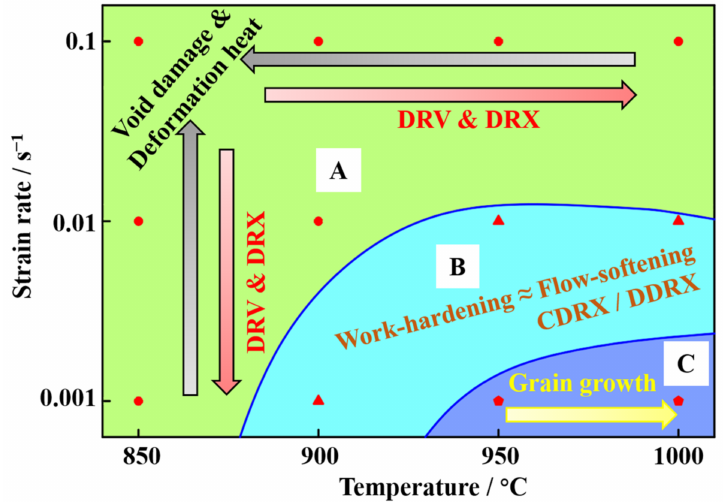
Figure 16. The hot deformation behaviors and the microstructure evolution mechanisms of the TC31 titanium